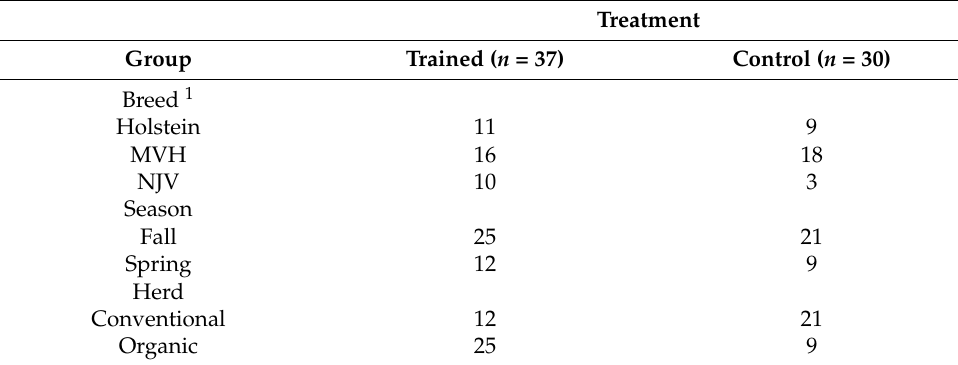
Table 1. Distribution of animals by treatment and